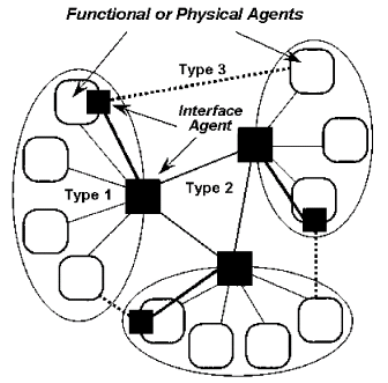
Figure 4. Hybrid network